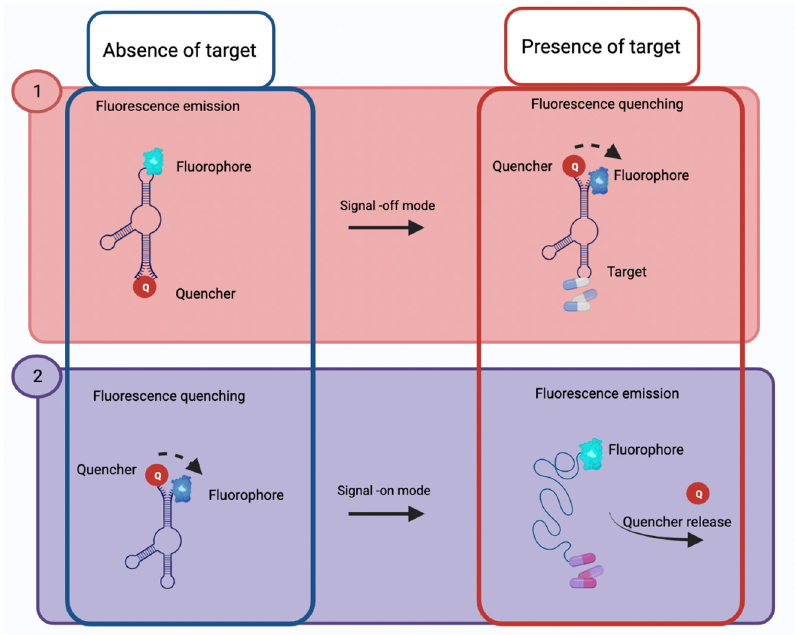
Figure 4. Schematic illustration representing two types of events in fluorescence aptasensors. ( 1 ) Signal-off mode, in which the aptamers release a fluorescence signal (in the absence of the target) since the fluorophore is far from the quencher; however, when the target is presented, the aptamer undergoes a conformational change, causing the fluorophore to approach the quencher and turn off the fluorescence signal. ( 2 ) Signal-on mode, in which the fluorophore is close to the quencher extinguishing the fluorescence signal (in the absence of the target), but if the target is presented, a conformational change occurs, releasing the quencher to bind to its target. Created with Biorender.com.